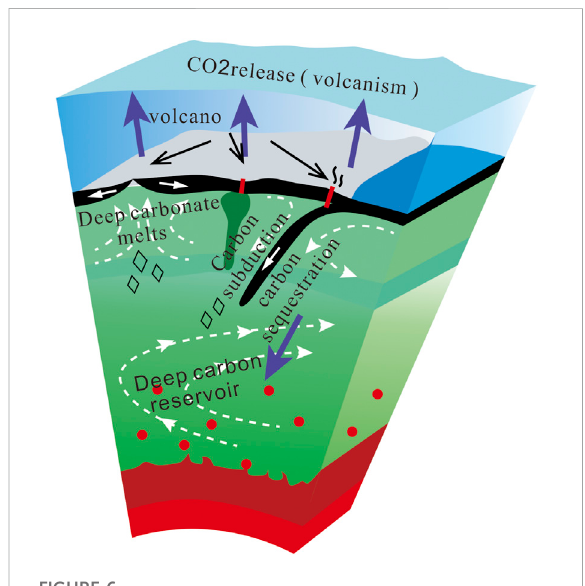
FIGURE 6 Phanerozoic deep carbon circulation modes (modi fi ed from Dasgupta (Dasgupta, 2013)